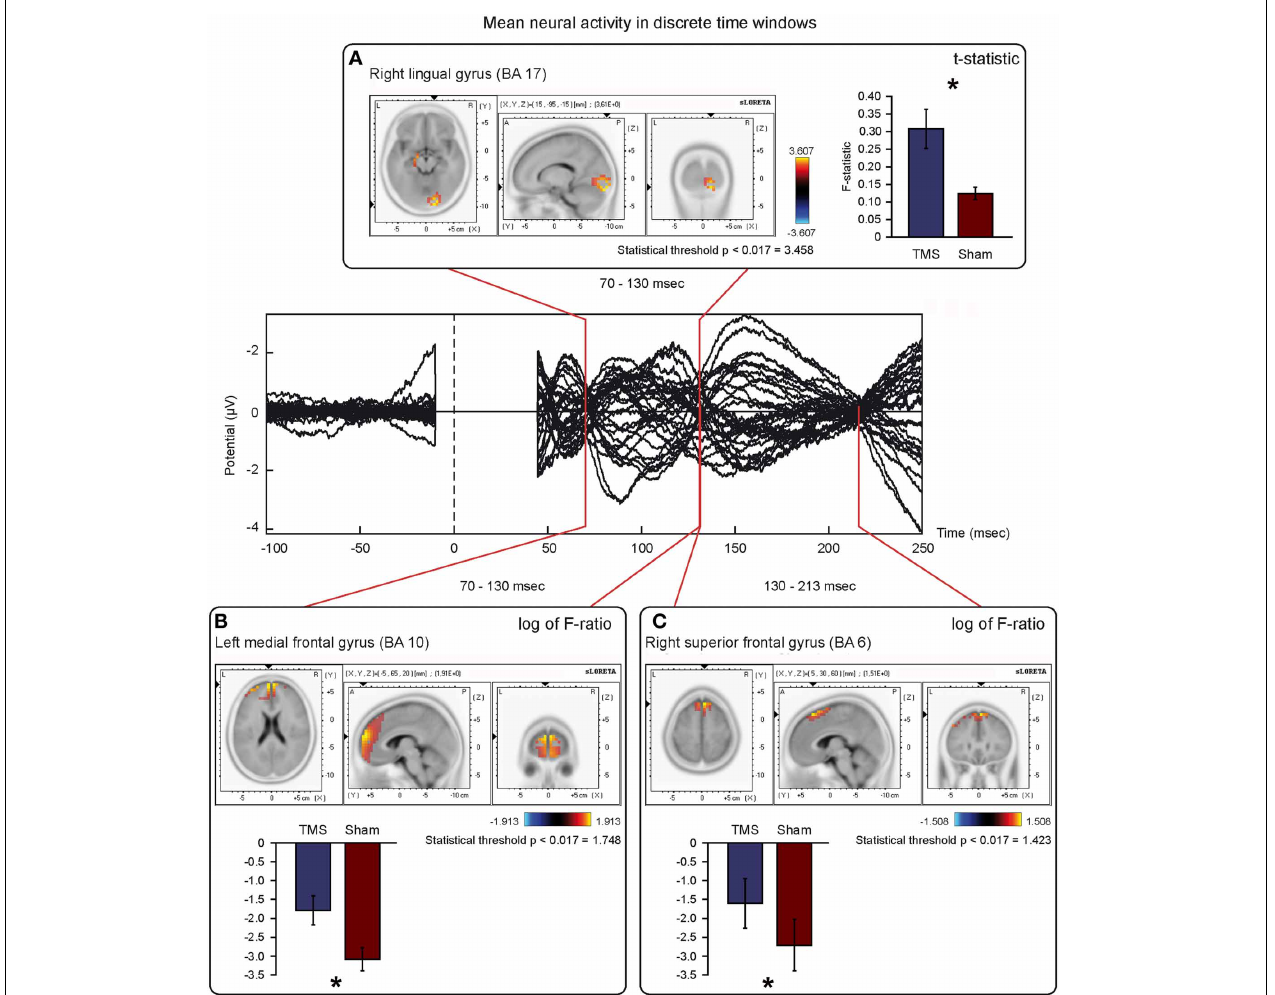
FIGURE 6 | Mean neural activity in discrete time windows of interest. Principal sLORETA results obtained when considering the mean of neural activity in discrete time windows and analysis performed with t- statistic (A) and log of F-ratio (B,C) . Statistics have been performed comparing the real TMS minus the sham conditions. Images are plotted with respect to the time windows identified in a butterfly plot of the evoked potentials obtained from the real TMS condition. (A) Mean results obtained in the 70–130ms time window with t- statistic. Activation with the maximal peak in the right lingual gyrus (BA 17) is shown. (B) Mean results obtained in the 70–130ms time window with log of F-ratio. Activation with the maximal peak in the left medial frontal gyrus (BA 10) is shown. (C) Mean results obtained in the 130–213ms time window with log of F-ratio. Activation with the maximal peak in the right